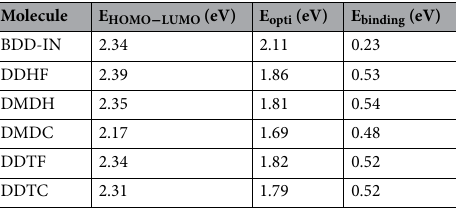
Table 4. Calculated E H − L , E opt , and E b of BDD-IN,